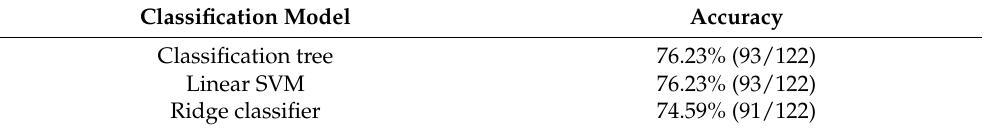
Table 4. Classification performance. Accuracy was estimated via leave-one-out cross-validation.